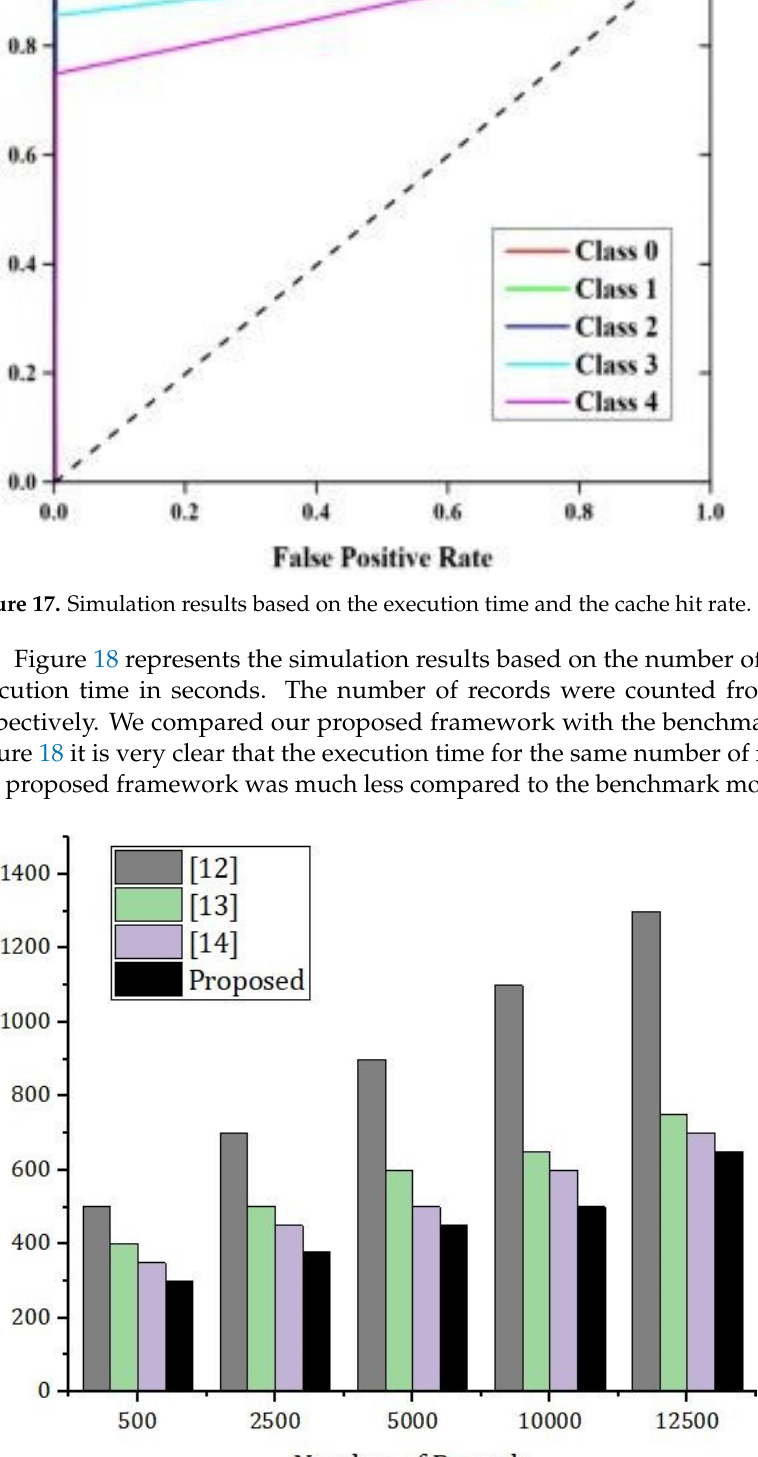
Figure 18. Simulation results based on the execution time and the cache hit rate.